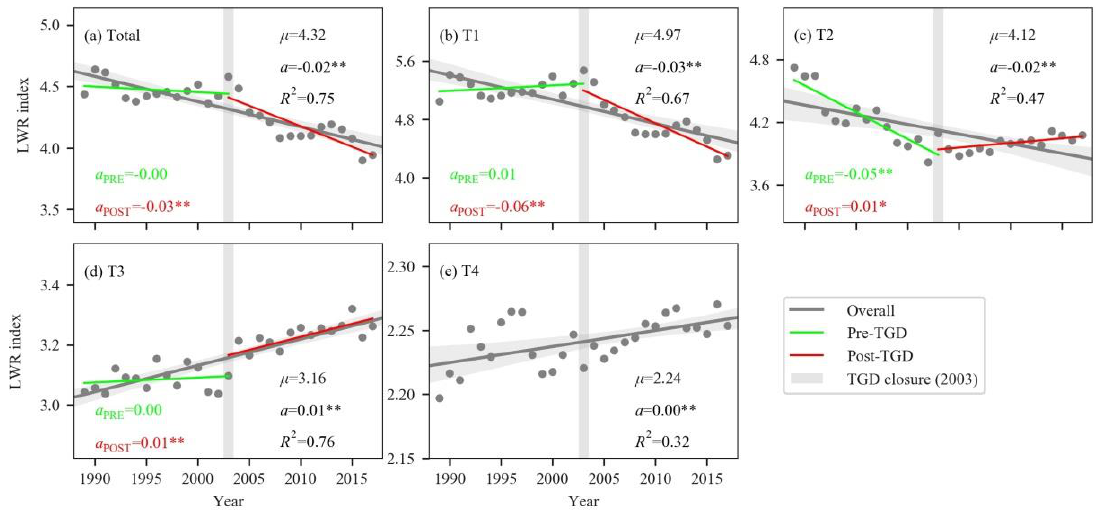
Figure 10. LWR temporal dynamics of different groups of MCBs: ( a ) Total MCBs, ( b ) T1 MCBs, ( c ) T2 MCBs, ( d ) T3 MCBs, and ( e ) T4 MCBs. The regression parameters a and R 2 stand for regression slope and coefficient of determination. Slope values with “*” and “**” indicate the corresponding p -value < 0.05 and < 0.01, respectively. Parameter μ stands for the mean value of LWR.